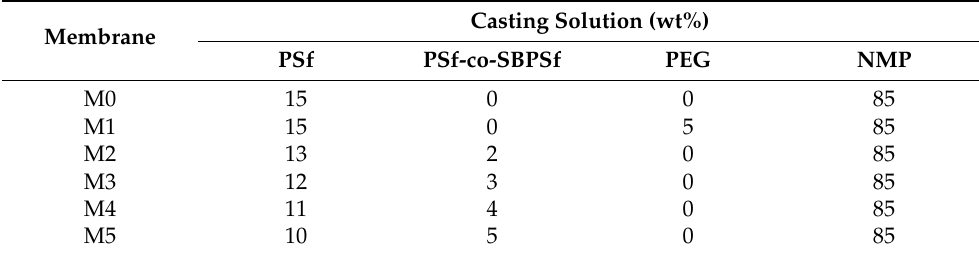
Table 1. Composition of various casting solutions.